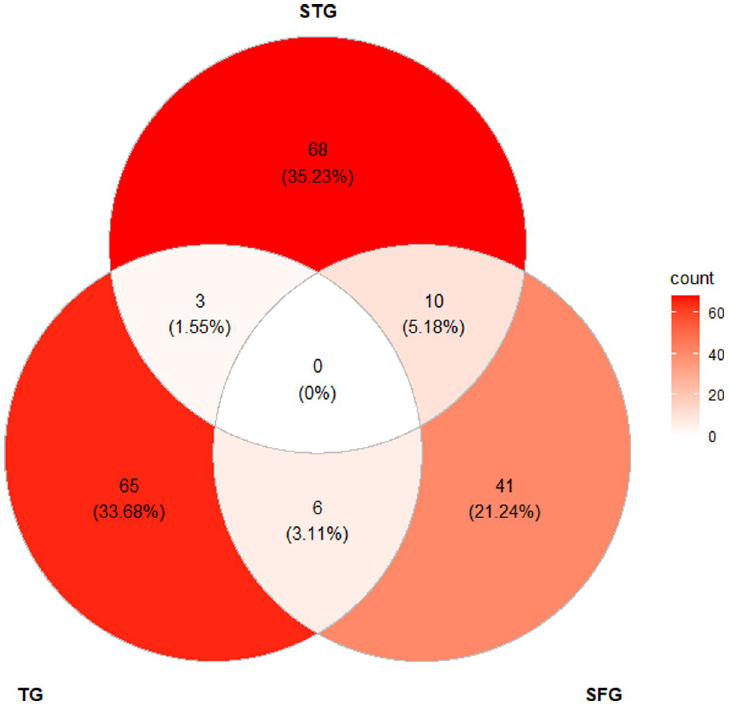
Fig 2. Venn diagram represents number of participants exposed with STG, TG, SFG and co-exposures. Relative proportions of the rickettsiosis exposures are provided in parentheses.